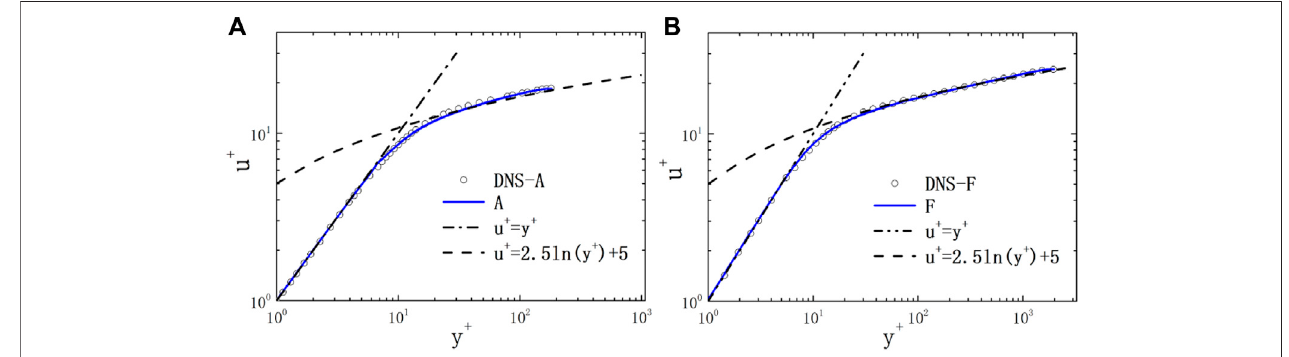
FIGURE 1 | Non-dimensional velocity of the plane. (A) case A; (B) case